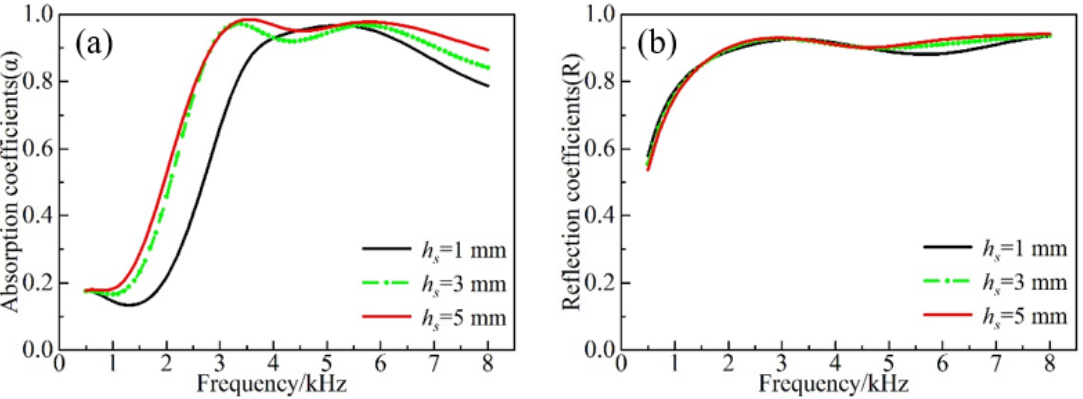
Figure 8. ( a ) Forward absorption and ( b ) backward reflection with different heights of scatterers.